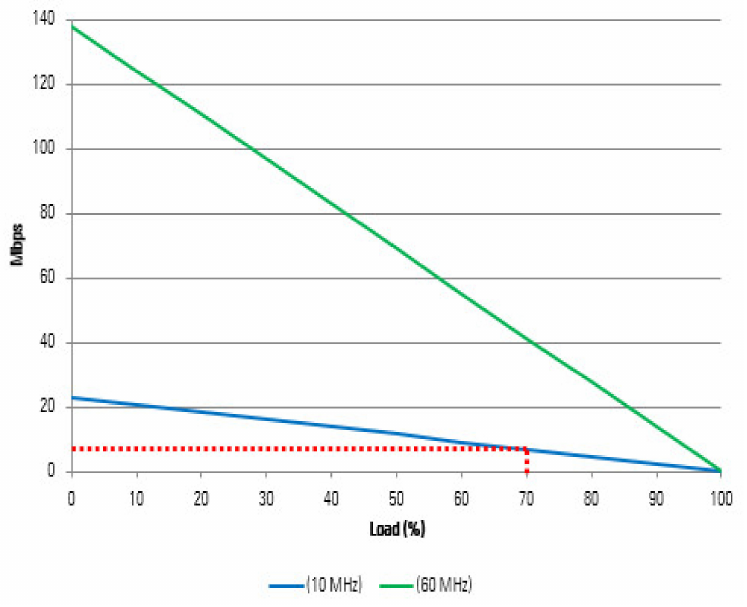
Figure 5. Throughput per